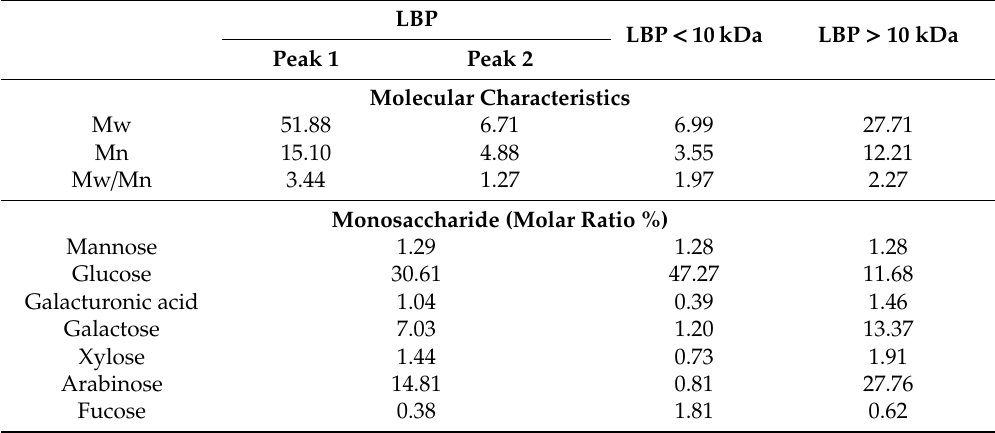
Table 1. Table 1. Structure Characterization of LBP fractions.